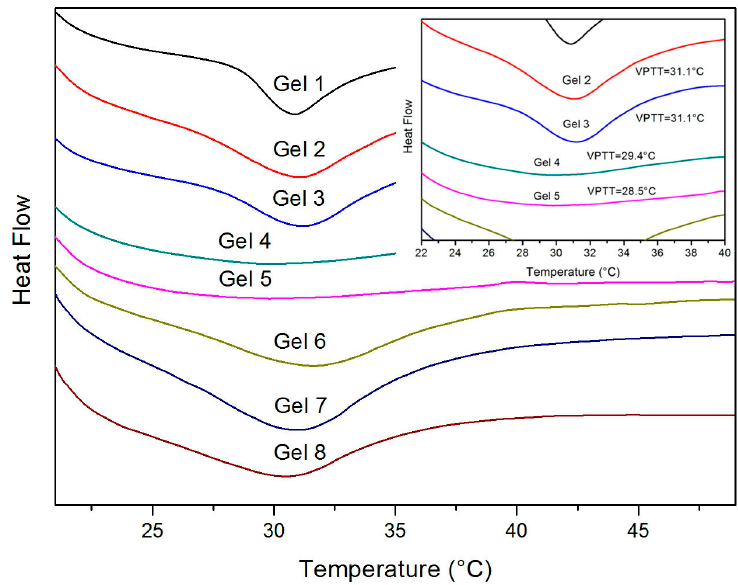
Figure 4. The phase transition behavior of gels measured by DSC.